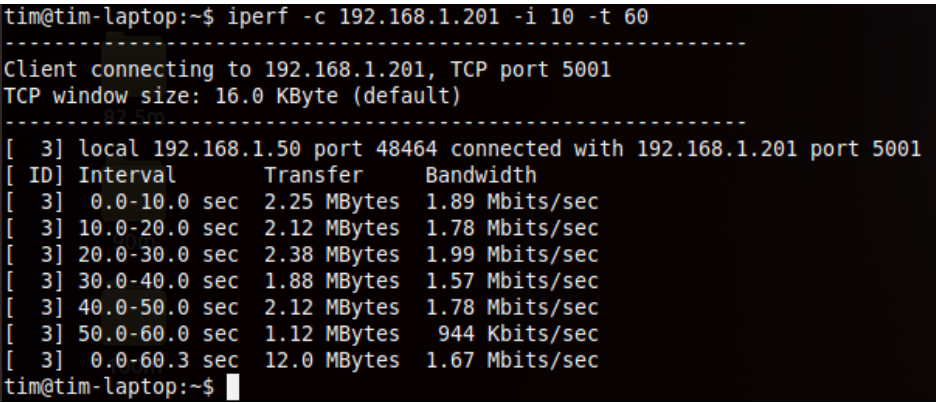
Figure 10. Sample bandwidth results for the stations that were connected to the WMN through the same channel with the backhaul connection.